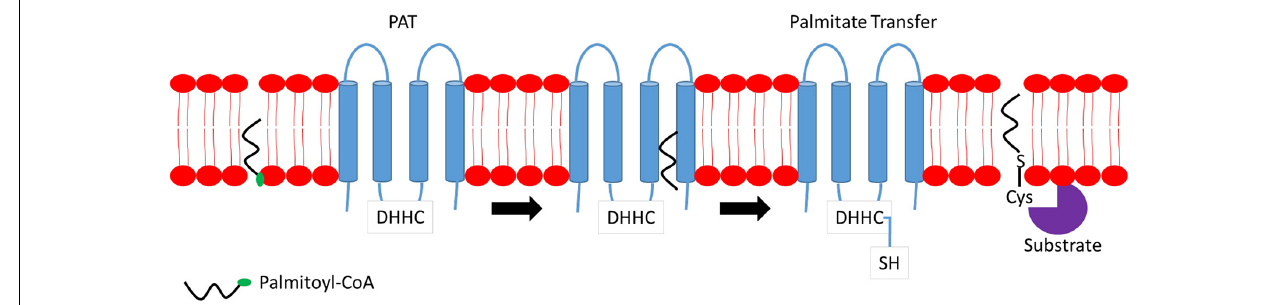
FIGURE 1 | Mechanism of action of palmitoyl S-acyltransferase (PAT). Briefly, Asp–His–His–Cys (DHHC) binds to palmitoyl-coenzyme A (CoA) located at the membrane and transfers a fatty acyl chain to the targeted substrate protein releasing